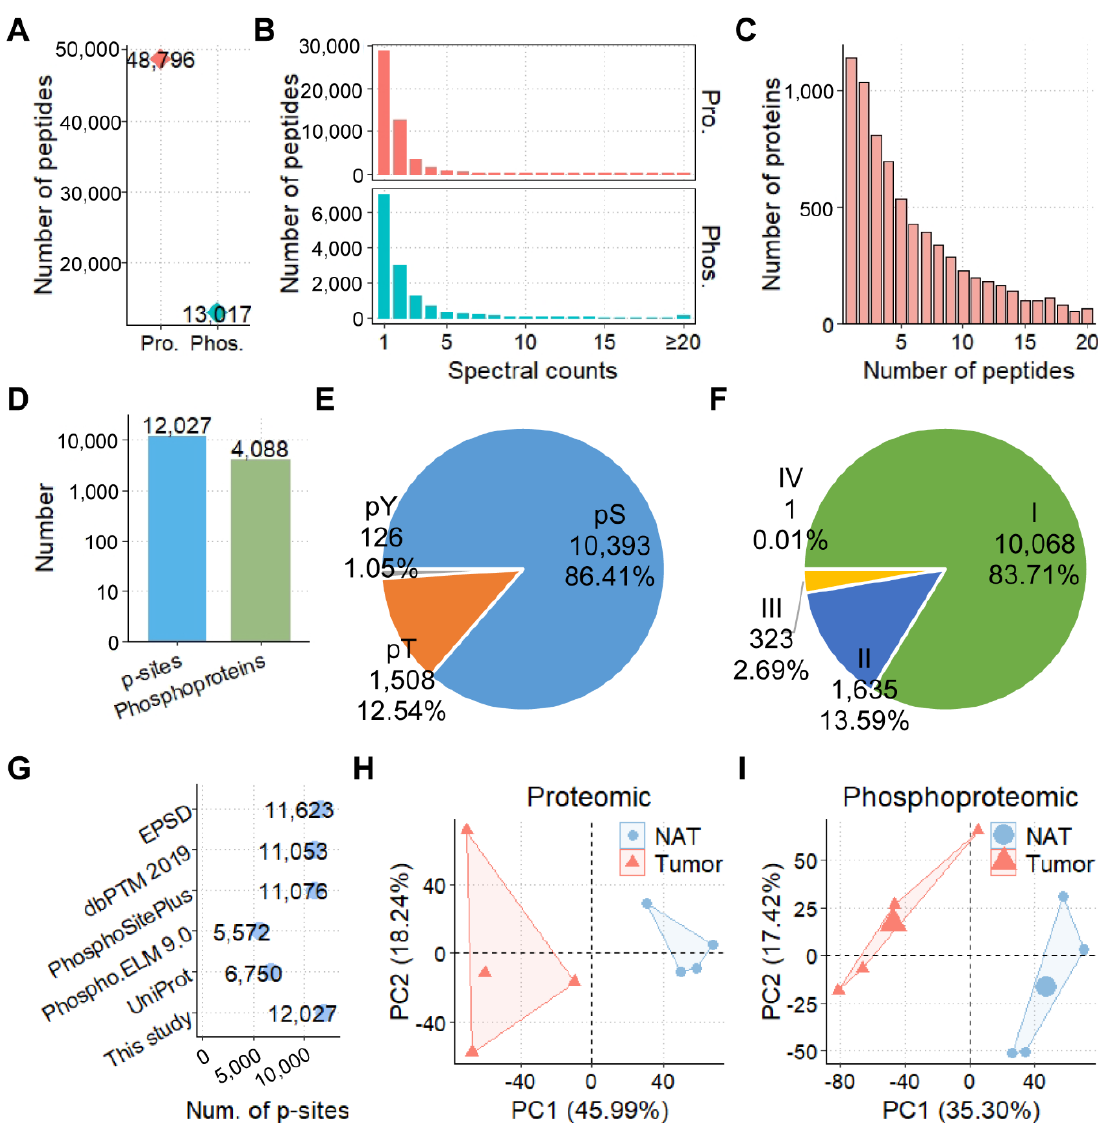
Figure 2. The proteomic and phosphoproteomic profiling of CCAs: ( A ) numbers of peptides and phosphopeptides identified in all samples; ( B ) distributions of MS/MS spectral counts of peptides and phosphopeptides obtained from proteomics and phosphoproteomics, respectively; ( C ) distribution of peptide numbers for quantified proteins; ( D ) numbers of identified p-sites and phosphoproteins; ( E ) distribution of quantified pS, pT, and pY residues; ( F ) the classification of p-sites based on LP scores; ( G ) comparison of identified p-sites with known p-sites curated from five public databases; and the PCA result of tumor and NAT samples from ( H ) proteomic and ( I ) phosphoproteomic data.